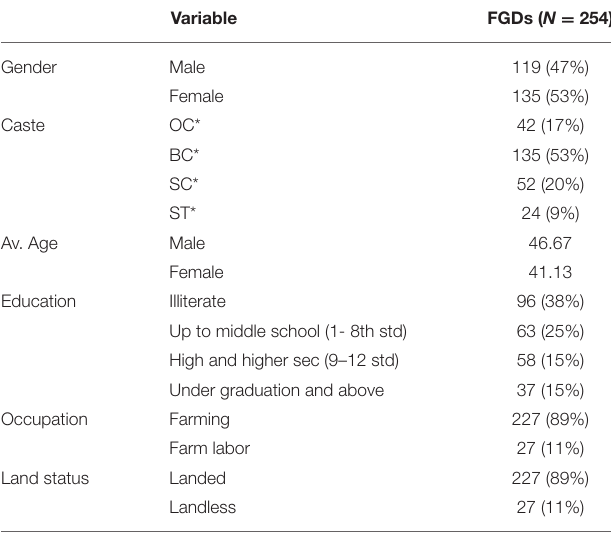
TABLE 3 | Sociodemographic characteristics of the survey